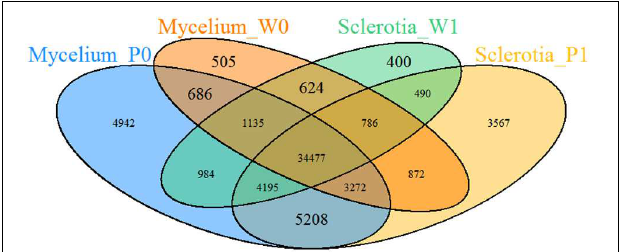
FIGURE 3 | The number of unigenes for mycelium and sclerotium from different two data sets. Mycelium_P0 and Sclerotia_P1 were from the data set sequence in this project and Mycelium_W0, Sclerotia_W1 were from Shu et al. (2013).